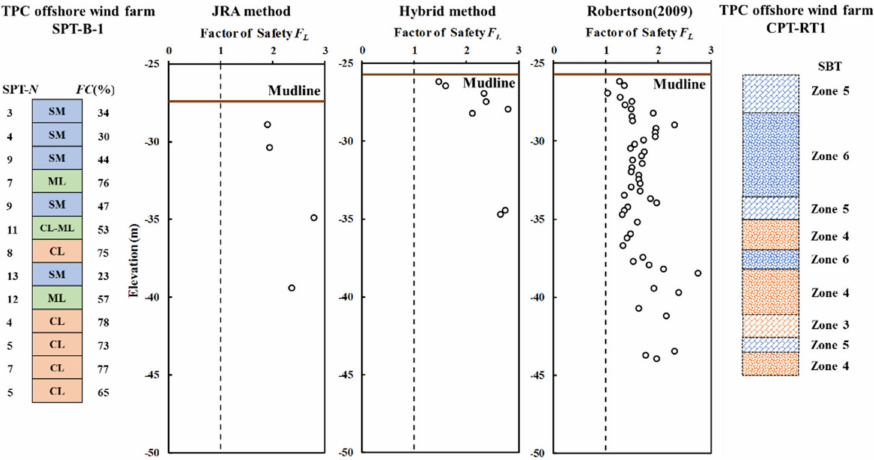
Figure 12. The soil liquefaction potential of boreholes CPT-RT1 and SPT-B1 in TPC offshore wind